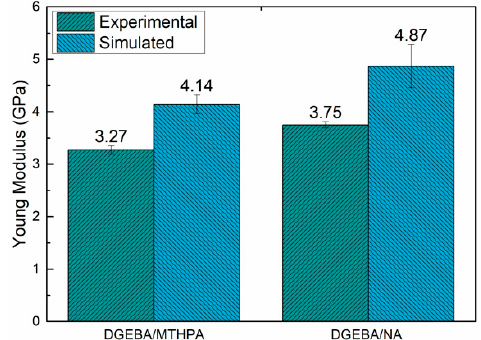
Figure 12. The simulation and experimental results of Young’s modulus.